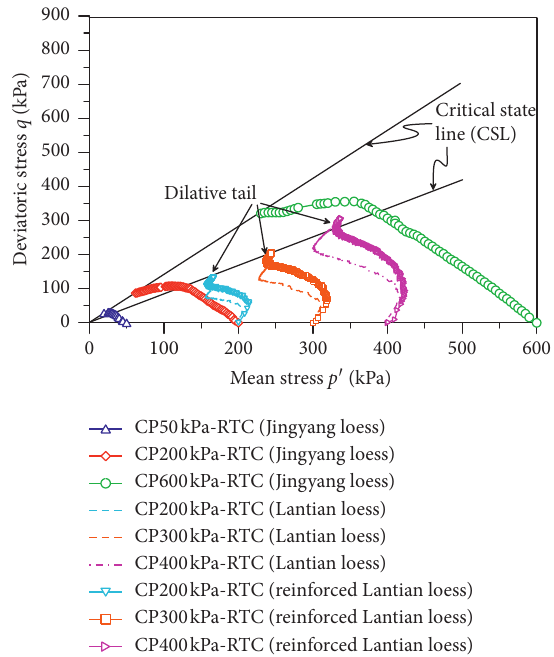
Figure 9: Effective stress paths of Lantian loess and Jingyang loess and failure line in p ′ − q